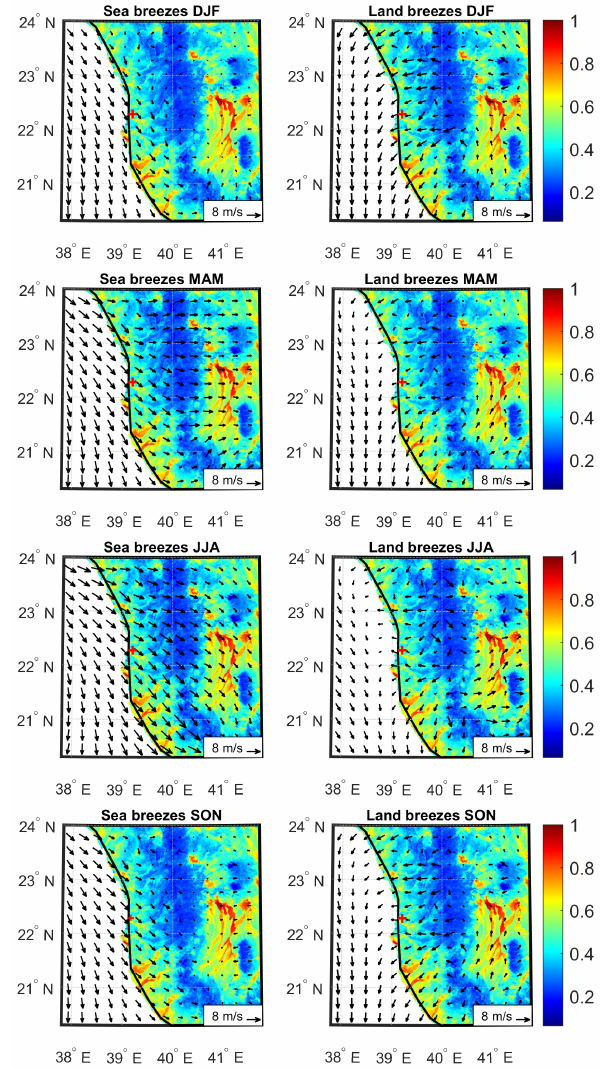
Figure 15. Model 10m wind speed showing the land (right) and sea (left) breezes. The data are averaged during the peaks of land and sea breezes to highlight their patterns, i.e., 01:00 to 03:00UTC for land breezes (night) and 14:00 to 16:00UTC for sea breezes (day). The KAUST site is marked by a red ( + ) mark. The base map shows the high-resolution dust source function (Parajuli and Zender, 2017) used in this study. The values range from zero to one, with the highest value representing the most significant dust